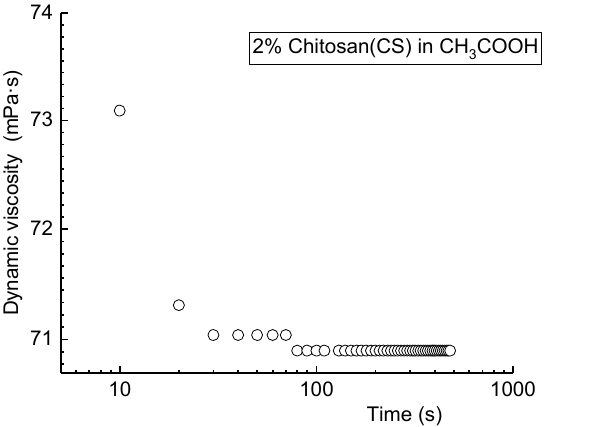
Figure 11. Dynamic viscosity versus time in logarithmic scale for CS solution in 2% acetic acid at 25 rpm spindle.